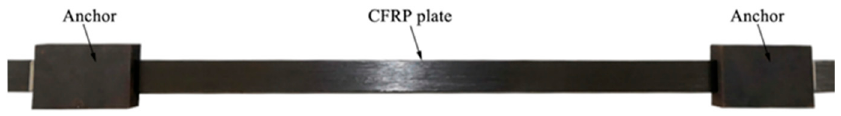
Figure 8. Compressive stress in CFRP plate vs. distance from small end of wedge.